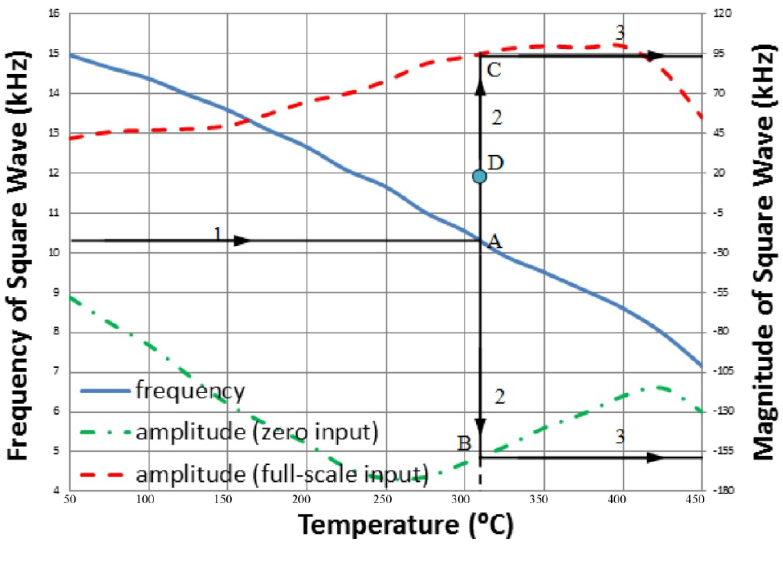
Figure 17. Characteristic curves of the wireless temperature sensing system